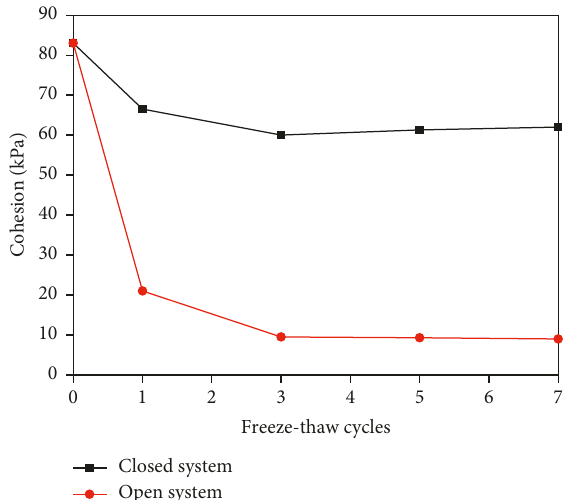
Figure 13: Variation of cohesion with the number of freeze-thaw cycles.